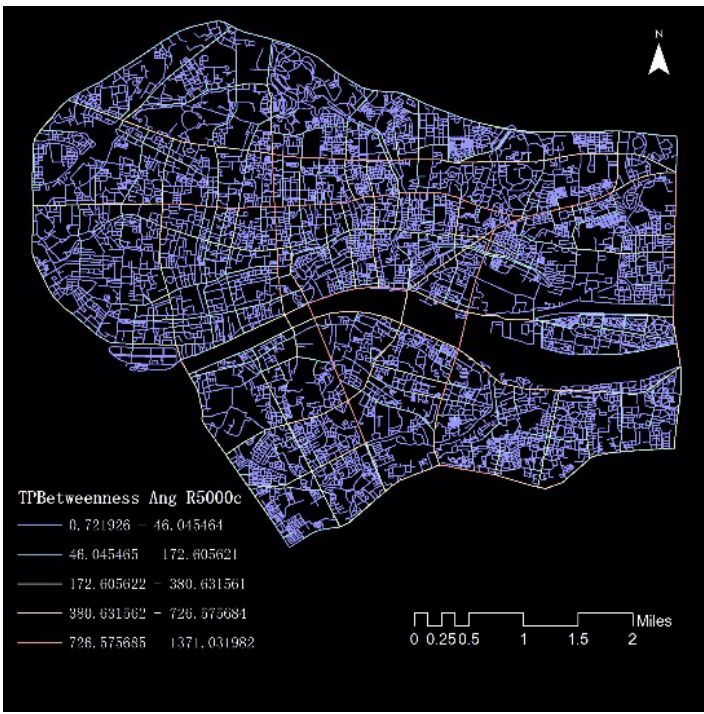
Fig. 21 Regional TPBt at a radius of 5000m